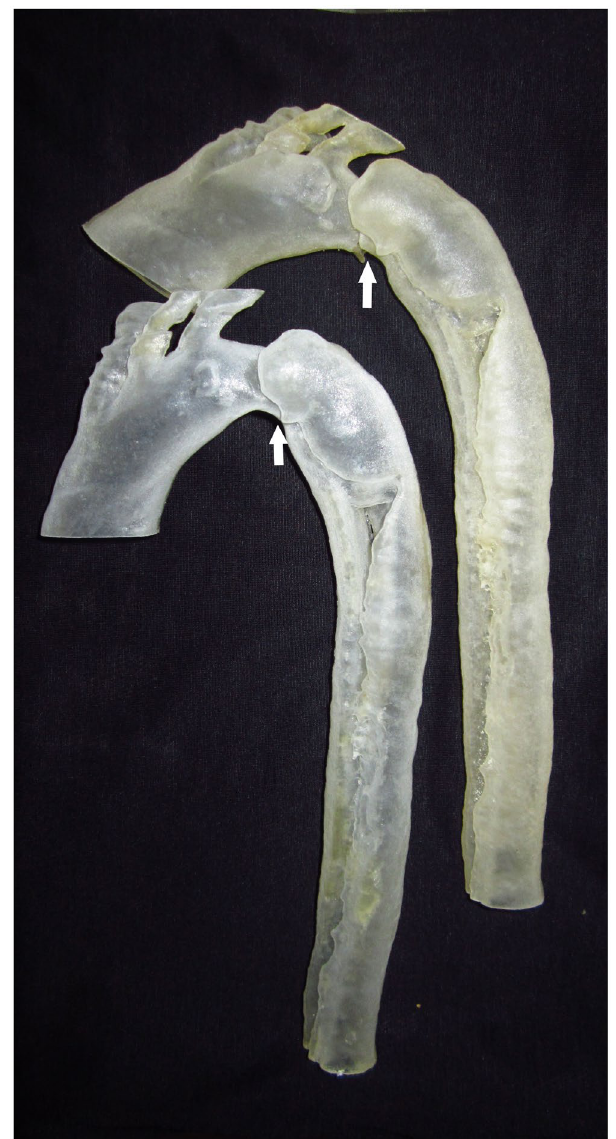
Figure 3. Three-dimensional model of a dissection. The top panel shows the possible shape after stent deployment. The white arrow indicates the maximum angle of the